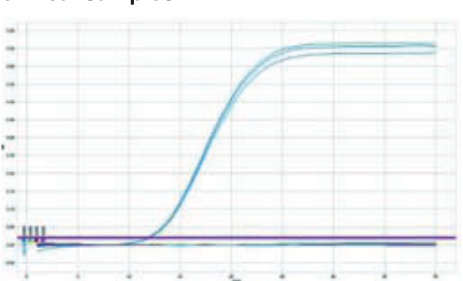
Fig.2 agarose gel electrophoresis of PcR amplified product of C . foetus subspecies